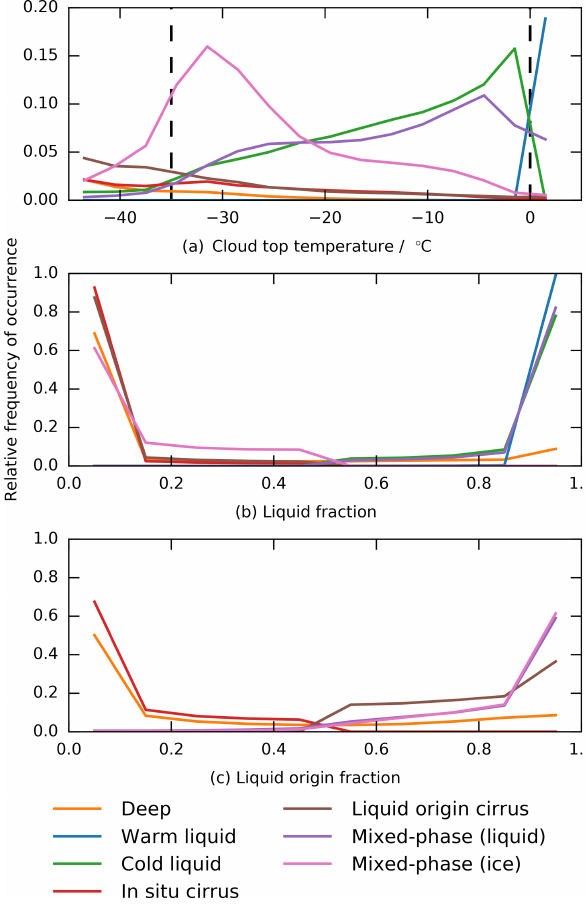
Figure 10. Relative frequency of cloud occurrence (normalized by the cloud type occurrence frequency). This corresponds to con- ditional probability histograms, P(X (cid:113) ∈ Bin | X ∈ Type i ) for the model state X with components X (cid:113) : cloud top temperature (a) , liq- uid fraction (b) and liquid origin fraction (c) for each cloud type i . Bin widths are 3 ◦ C for temperature and 0.1 for the dimensionless fractions respectively; lines are aligned with bin centres. Data are sampled every time step for 10 years of simulation with the new model